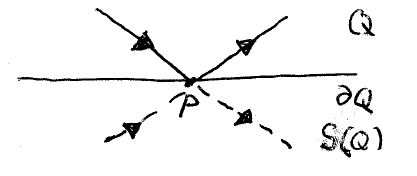
Figure 12. Continuation of a billiard motion in the quadrilateral Q to a billiard motion in the quarilateral S ( Q ) obtained by the reflection S in an edge of Q